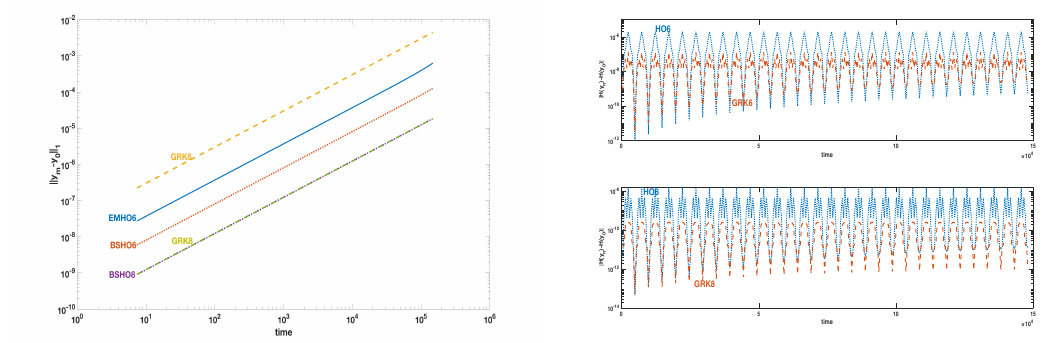
Figure 3. Nonlinear pendulum problem: results for the Hermite–Obreshkov method of order six and eight (BSHO6, red, and BSHO8, purple dotted lines), for the sixth order Euler–Maclaurin (EMHO6, blue solid line) and Gauss methods (GRK6, yellow, and GRK8, green dashed lines) applied to the pendulum problem. ( Left ) plot: absolute error of the numerical solution; ( upper-right ) and ( bottom-right ) plots: error in the Hamiltonian function for the sixth order and eighth order integrators,